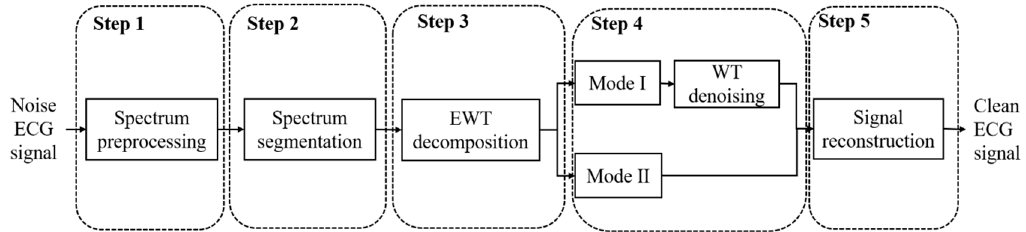
Figure 2. The flowchart of the EWT-WT motion artifact removal method.